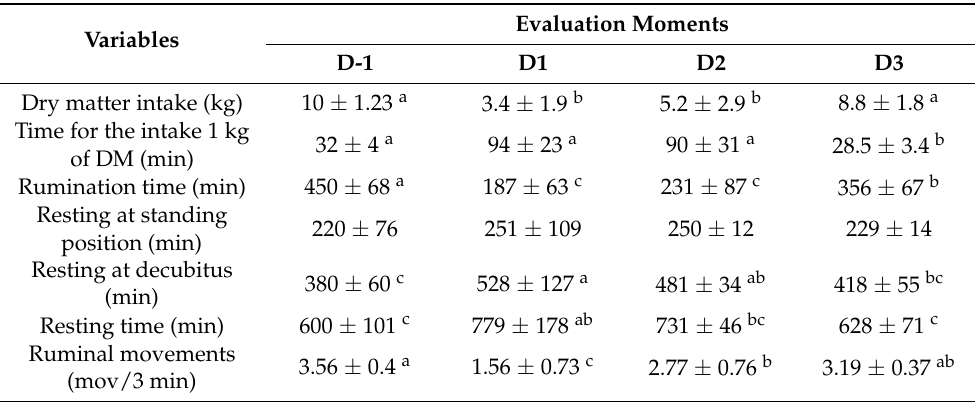
Table 3. Behavioral variables of cattle subjected to subacute ruminal acidosis (SARA) induction with the use of citrus pulp. Evaluation Moments Variables D-1